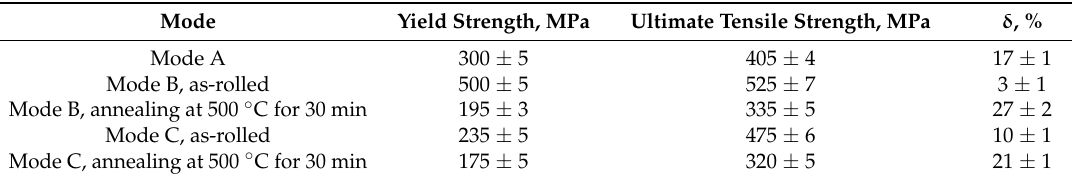
Table 3. Mechanical properties at room